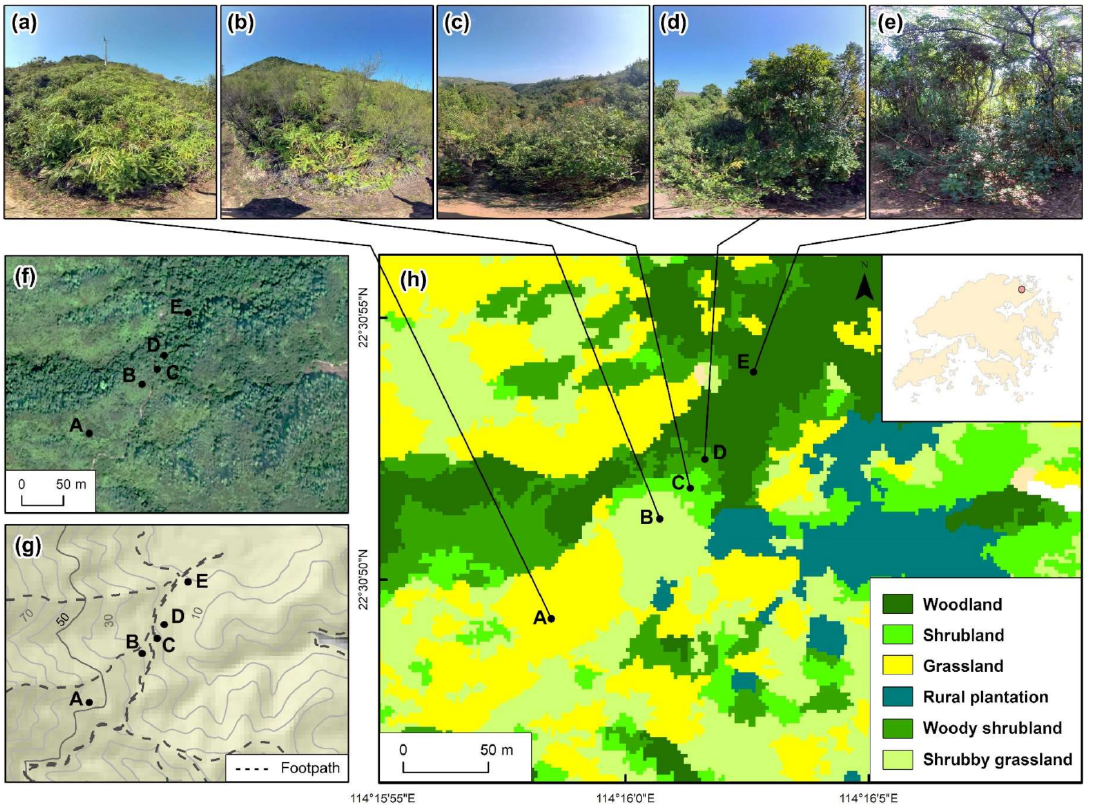
Figure 11. A selected site showing the transition from grassland (Point A) to woodland (Point E) within a short distance; ( a ) photo of point A taken in the field. Species included Dicranopteris pedata , Blechnum orientale ; ( b ) photo of point B taken in the field. Species included Baeckea frutescens , Dicranopteris pedata ; ( c ) photo of point C taken in the field. Species included Rhaphiolepis indica , Baeckea frutescens ; ( d ) photo of point D taken in the field. Species included Schefflera heptaphylla , Rhodomyrtus tomentosa ; ( e ) photo of point E taken in the field. Species included Cinnamomum camphora , Aporosa dioica ; ( f ) true-colour composite of the WorldView image; ( g ) topographic map; ( h ) habitat map produced in this